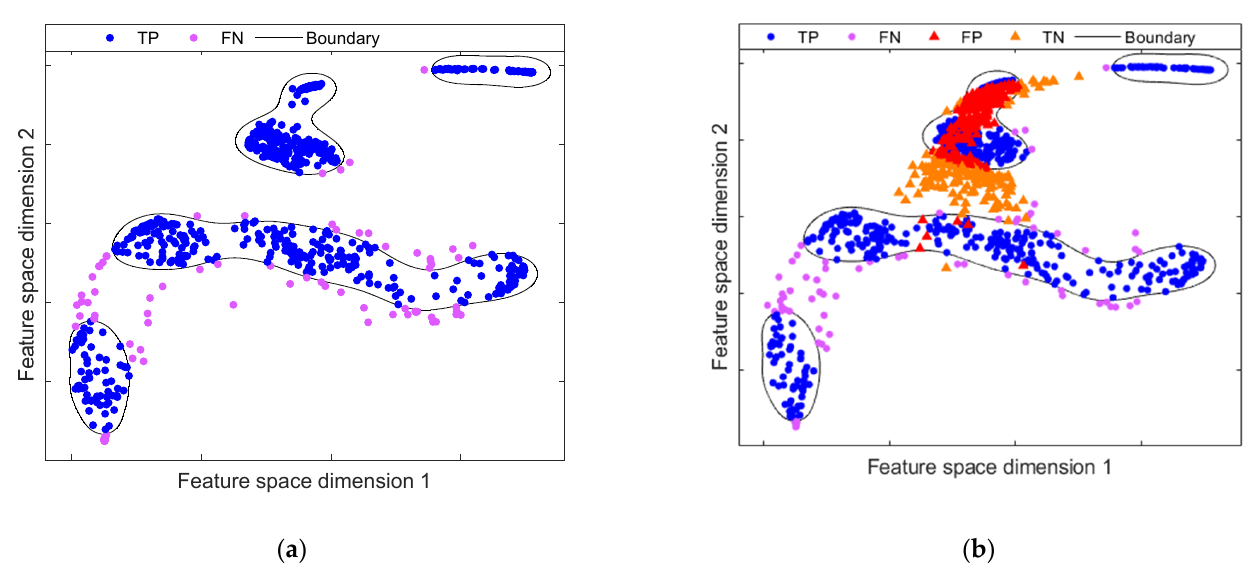
Figure 7. Anomaly detection model on feature space mapping resulting from DAE by means OC-SVM: ( a ) initial anomaly model representation. The anomaly model is trained employing data from He condition and F1 condition; ( b ) evaluation of the fault scenario F2, showing a high overlap between known and unknown classes.